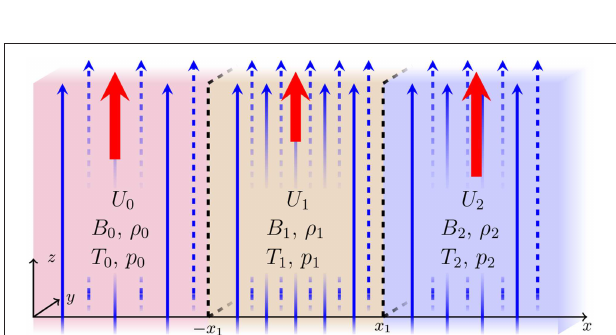
FIGURE 9 | The equilibrium configuration for a steady and magnetized slab embedded in a steady, magnetized, and asymmeric semi-infinite plasma. The notation is the same as in the previous figures, with the addition of the thick red arrows representing the vertical plasma flow, U ( x )